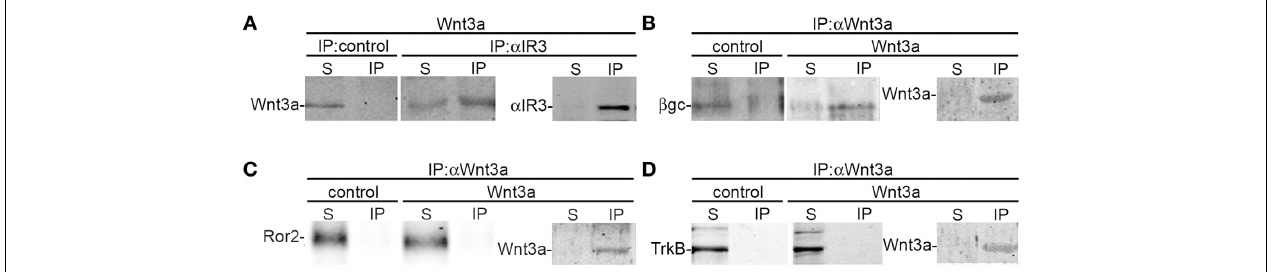
FIGURE 5 | Wnt3a interaction with IGF-1r. (A) Growth cone particles were stimulated with Wnt3a and immunoprecipitated with a non-relevant primary antibody (IP control) or the α IR3 antibody to pull down IGF-1r. Blots were probed with an anti-Wnt3a antibody. Immunoprecipitation of α IR3 is shown to confirm successful IP and as a loading control. (B–D) Growth cone particles were incubated in control buffer or in the presence of 1.35nM